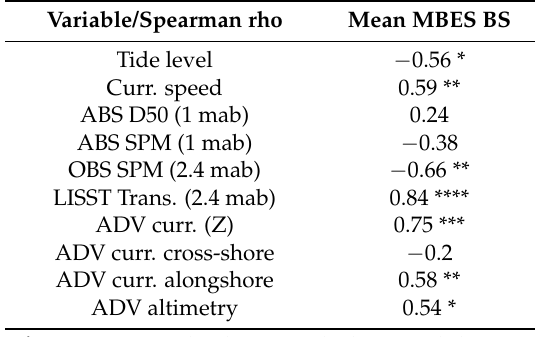
Table 5. Correlation matrix obtained by the Spearman rank method (lower triangle shown). Significance levels of the correlations are denoted by asterisks: Legend of the significance in the bottom row of the table. Values in italic = >